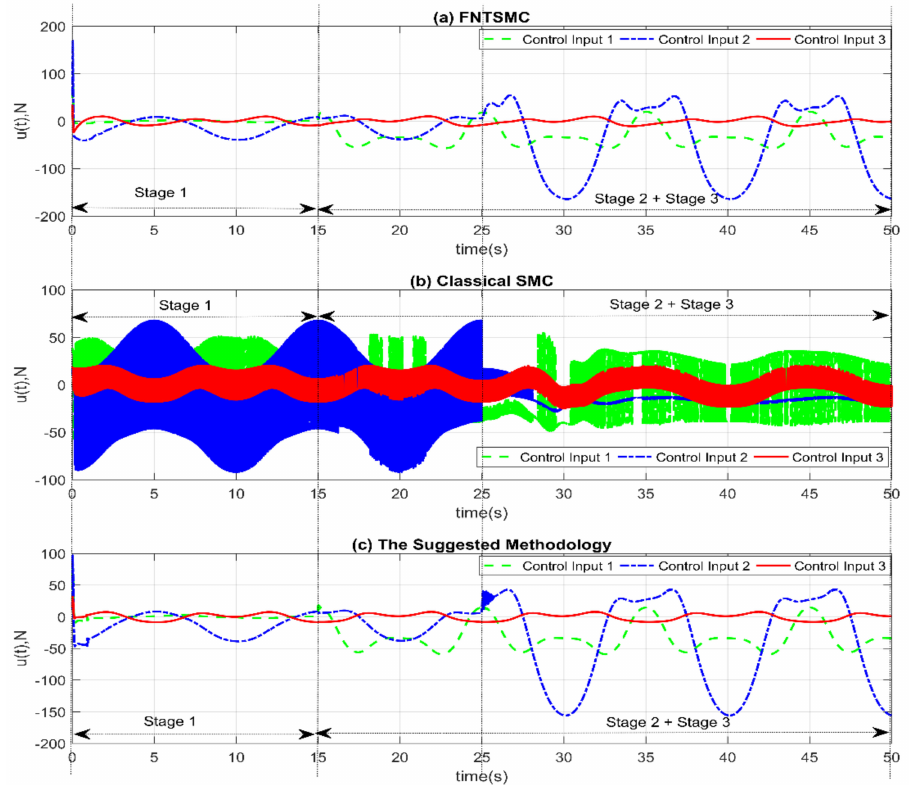
Figure 5. Control input signals: ( a ) FNTSMC, ( b ) classical SMC, and ( c ) the suggested control methodology. FNTSMC = fast nonsingular terminal sliding mode control.